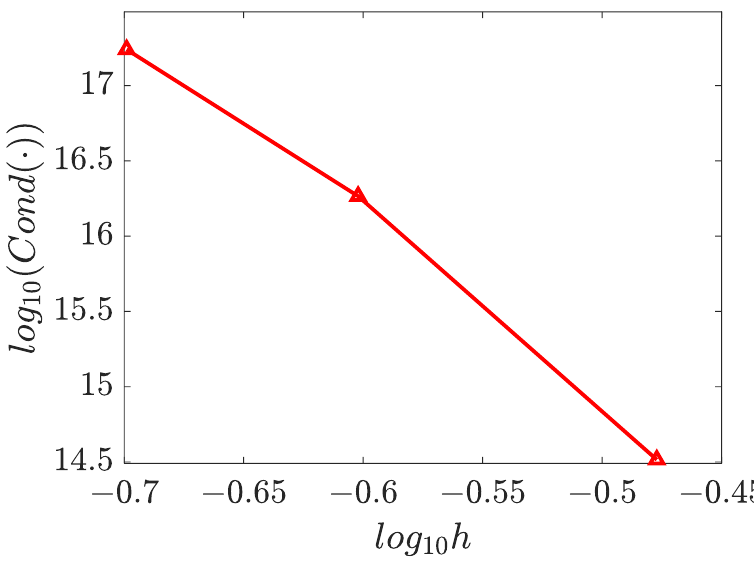
Figure 32. Condition number of stiffness matrix for the 3D parameter identification problem in spherical domain.